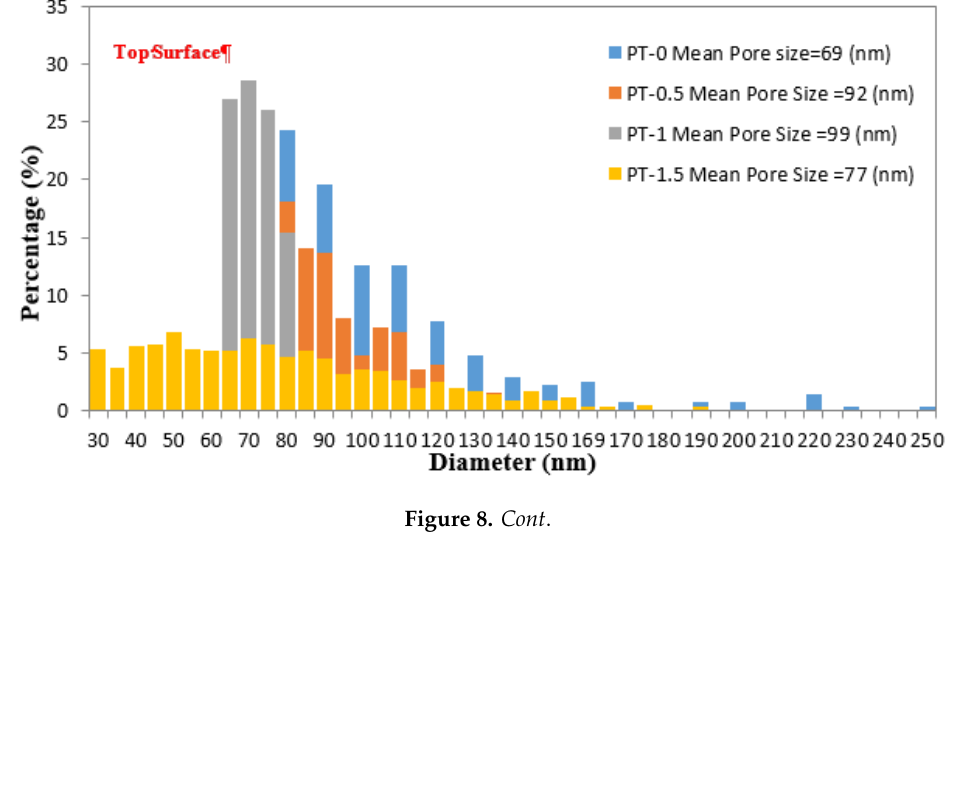
Figure 8. Pore size distribution of the ( top) and ( bottom) surfaces of the PVC membranes at different TiO 2 amounts: (PT-0) 0 gm TiO 2 ; (PT-0.5) 0.5 gm TiO 2 ; (PT-1) 1 gm TiO 2 ; and (PT-1.5) 1.5 gm TiO 2 . 3.7. Mechanical Tensile Test Compared to many other polymers, PVC has excellent mechanical properties, giving the PVC membrane the strength to deal with transmembrane pressures. The tensile strength at break of the PVC-TiO 2 -NPs membranes was higher than 2 MPa, as shown in Table 5. Implanting TiO 2 -NPs in the membranes led to a slight improvement in the tensile strength of the PVC-TiO 2 -NPs membranes because of the reinforcement effect of TiO 2 -NPs. The PT-0 tensile strength was 2.098 MPa, which increased to 2.281 MPa for PT-1.5. This may have been due to the uniform dispersion of the TiO 2 nanoparticles in the polymer solution during the synthesis of membranes, which leads to homogeneity of the casting solution and increased tensile strength. These results closely resemble the results of Yu et al. [10] and Alsalhy et al. [5]. It is worth to mention here that the improvement in tensile strength makes the composite PVC-TiO 2 -NPs membranes less prone to tearing during handling. Table 5. Tensile strength of prepared membranes. Materials Type